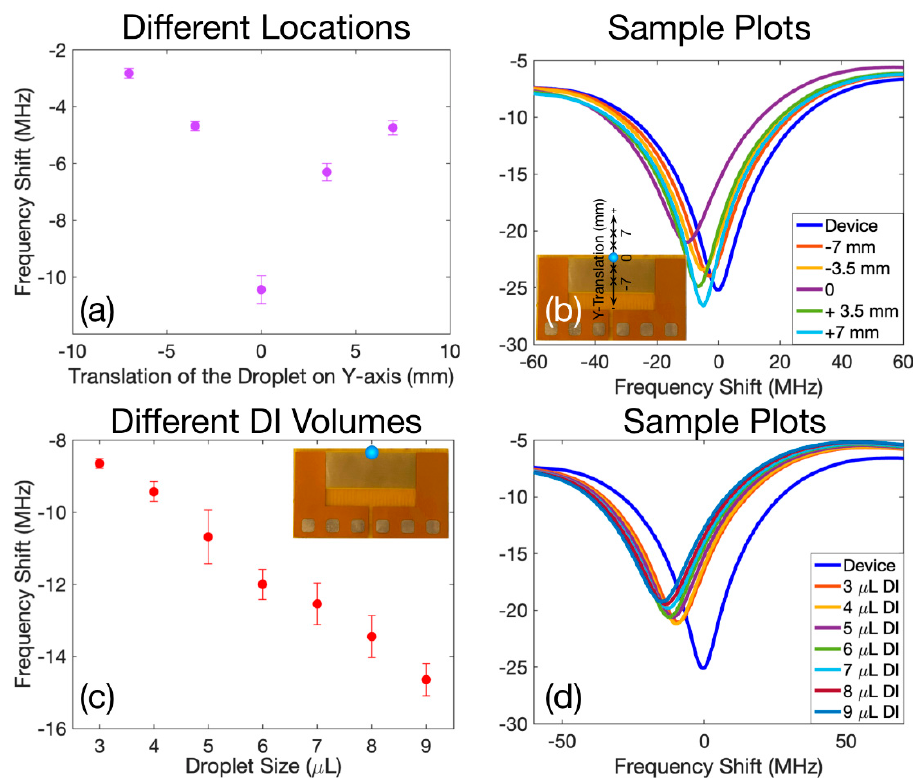
Figure 6. ( a ) The average shift in resonant frequency when a DI droplet was translated along the y-axis relative to a reference point on the upper IDTs and compared to the case, where a droplet is absent. ( b ) Sample S 11 spectra of the experiments corresponding to transiting DI droplet on y-axis. The inset represents the resonator, the reference point, and the employed locations. ( c ) The average shift in the resonant frequency when a DI droplet with various volumes was placed on the reference point (as illustrated in the inset) relative to the case, where the droplet is absent on the structure. ( d ) Sample S 11 spectra corresponding to the experiments where the volume of the droplet on the reference point was changed.